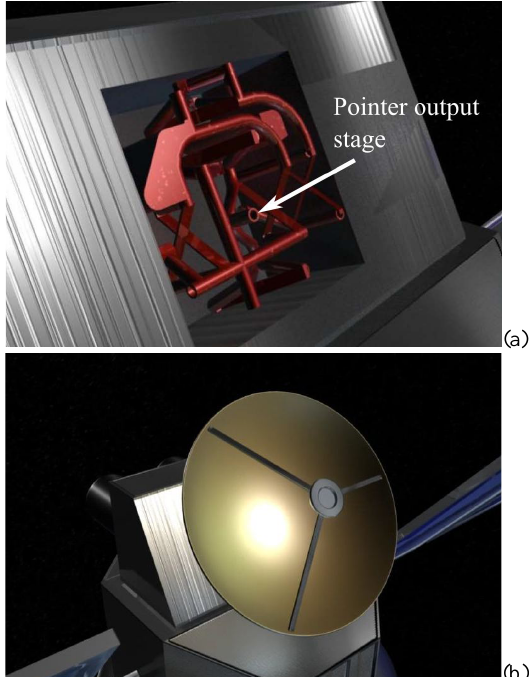
Figure 14. Possible application of the pointer for orienting a com- munications antenna. To see the full video, go to http: // youtu.be / xIAvIIoRw8w. (a) The pointer mechanism on a possible satellite. (b) The same satellite as in 14a, with communications antenna mounted to the pointer output stage.